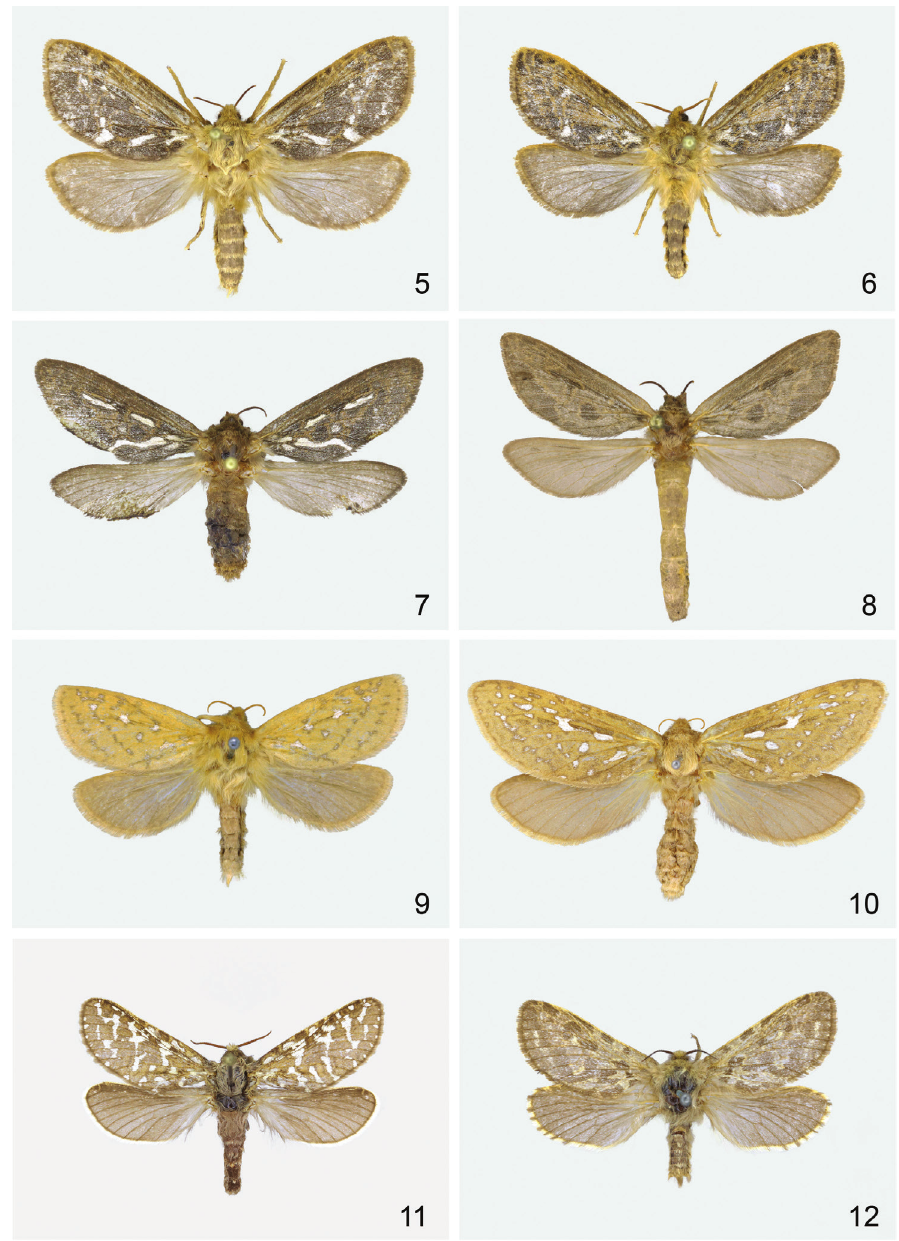
Figures 5–12. Pharmacis species. 5–8. P. cantabricus sp. n., Spain, Picos de Europa. 5. Male, holotype, alar expanse 33 mm (MfN). 6. Male, paratype, alar expanse 30 mm. (CAK). 7. Female, paratype, alar expanse 31 mm (CAK). 8. Female, paratype, alar expanse 35 mm (CFG). 9–10. P. aemilianus , Italy, Abbruzi, Pesco- costanzo. 9. Male, alar expanse 34 mm (MfN). 10. Female, alar expanse 52 mm (MfN). 11. P. pyrenaicus pyrenaicus , male, France, Pyrenees, alar expanse 25 mm (CAK). 12. P. pyrenaicus alticola , male, Pyrenees, alar expanse, 27.5 mm